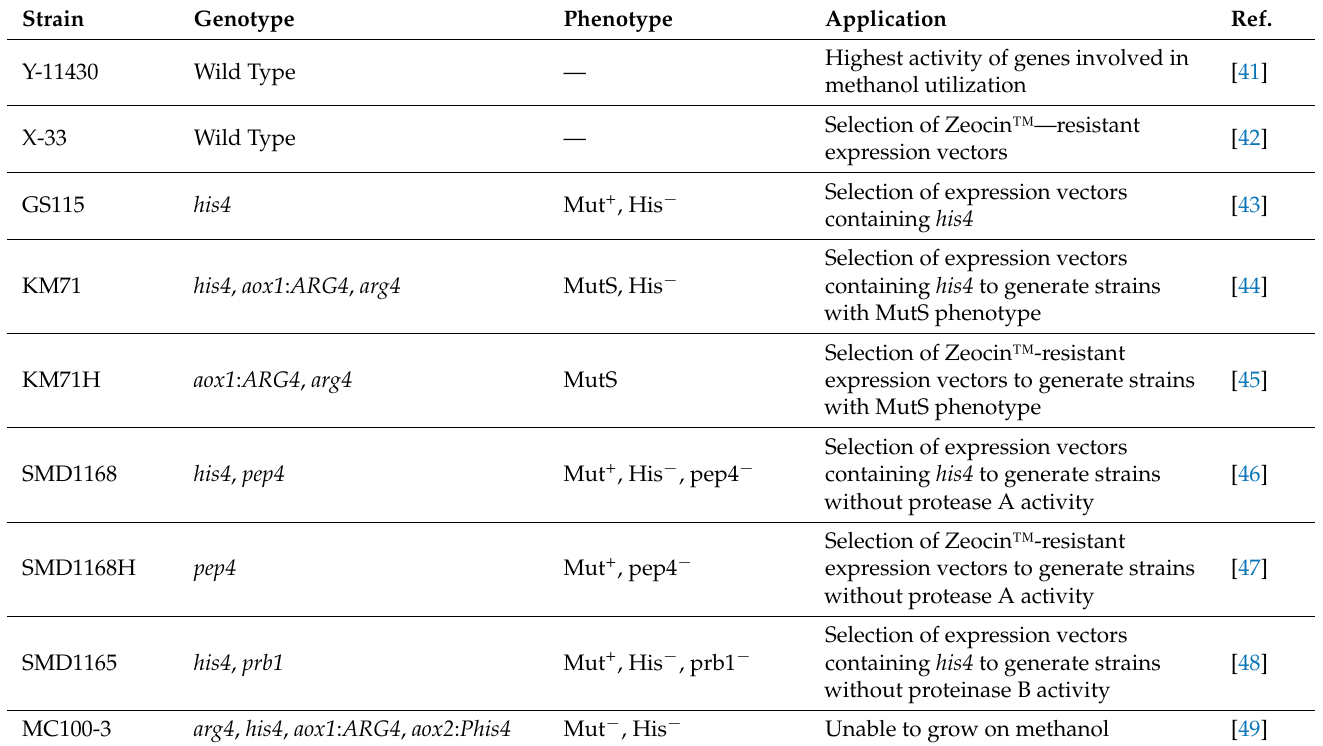
Table 1. Examples of K. phaffii host strains for basic and applied studies reported in